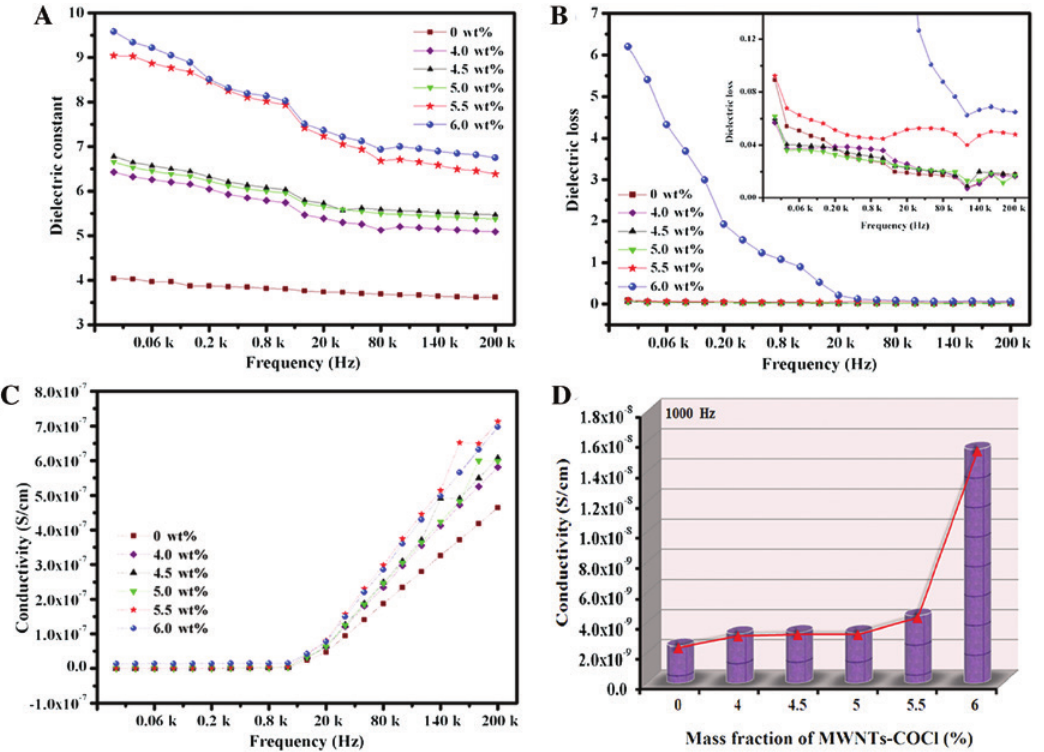
Figure 3: Dielectric properties of PEN-MWNT films depending on the MWNTs-COCl content: (A) dielectric constant and (B) dielectric loss. DC conductivity of PEN-MWNT films: (C) frequency dependence and (D) at 1